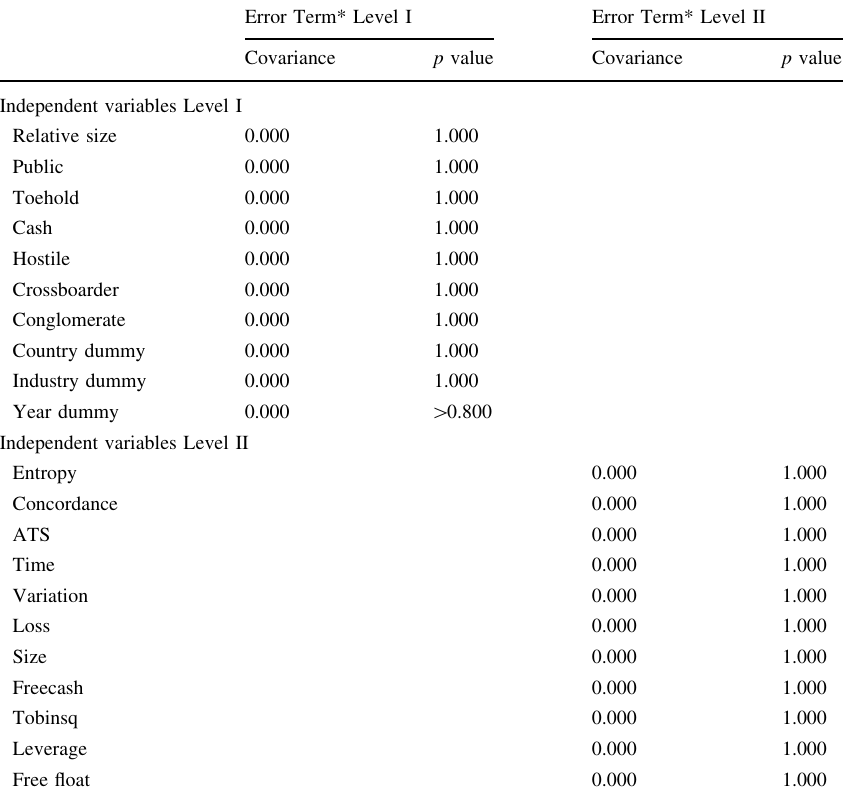
Table 5 Test assumptions linear regression – Endogenity